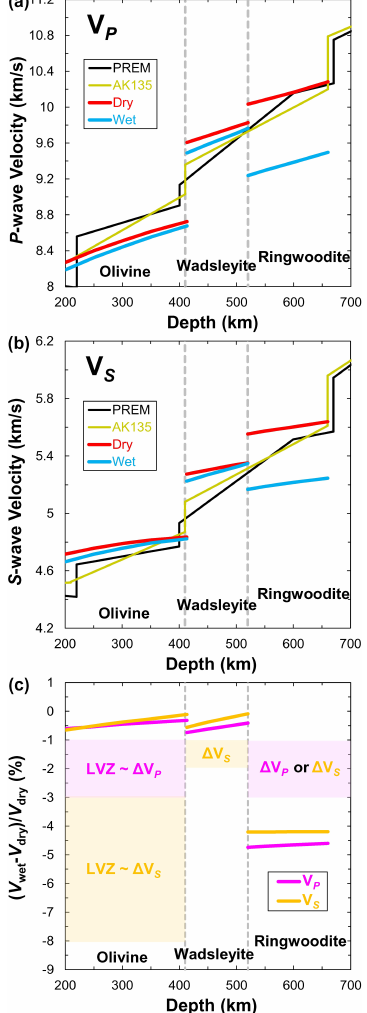
Figure 18. Influence of water on the mantle velocity struc- ture. (a) Compressional ( V P ) and (b) shear wave ( V S ) veloci- ties of olivine polymorphs in the Earth’s mantle along an adia- batic mantle geotherm (Katsura et al., 2010) compared with seis- mic models (PREM: Dziewonski and Anderson, 1981; AK135: Kennett et al., 1995). Red lines denote the velocity of anhydrous (Mg 0 . 9 Fe 0 . 1 ) 2 SiO 4 olivine polymorphs. Light blue lines represent the velocity of hydrous (Mg 0 . 9 Fe 0 . 1 ) 2 SiO 4 olivine, wadsleyite, and ringwoodite with 0.4wt.%, 2.0wt.% and 1.0wt.% H 2 O, respec- tively, based on the data sources (Li et al., 1996, 2003; Sinogeikin et al., 2003; Jacobsen and Smyth, 2006; Higo et al., 2008; Wang et al., 2014; Mao et al., 2010, 2011, 2012, 2015; Buchen et al., 2018). (c) Comparison of water-induced reduction in velocity of (Mg 0 . 9 Fe 0 . 1 ) 2 SiO 4 olivine polymorphs in the Earth’s mantle with the low-velocity anomalies in the mantle revealed by seismic ob- servations in the UM (e.g., Song et al., 2004; Kawakatsu et al., 2009; Tauzin et al., 2010; Schmerr, 2012) and MTZ (Sieminski et al., 2003; Kustowski et al., 2008; Houser and Williams, 2010; Schmandt et al.,